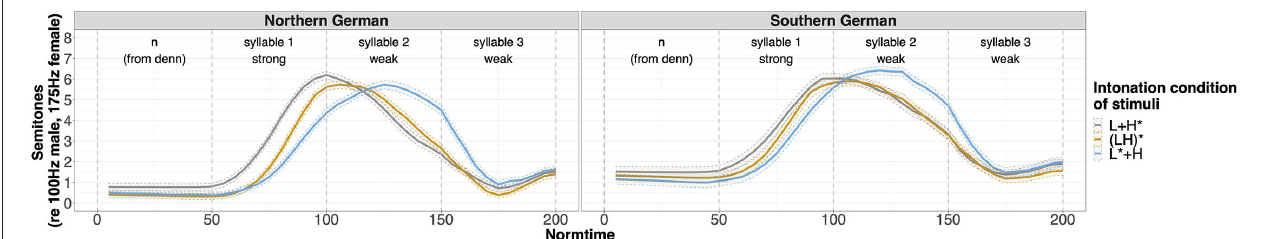
FIGURE 3 | Average f0 contours (in st) of imitative productions in the three different intonation conditions [L + H* in gray, (LH)* in orange, and L* + H in blue], for Northern German (left) and Southern German speakers (right). The x-axis displays the time-normalized questions (from [n] of the particle denn followed by the trisyllabic sentence-final object, e.g., Mandalas